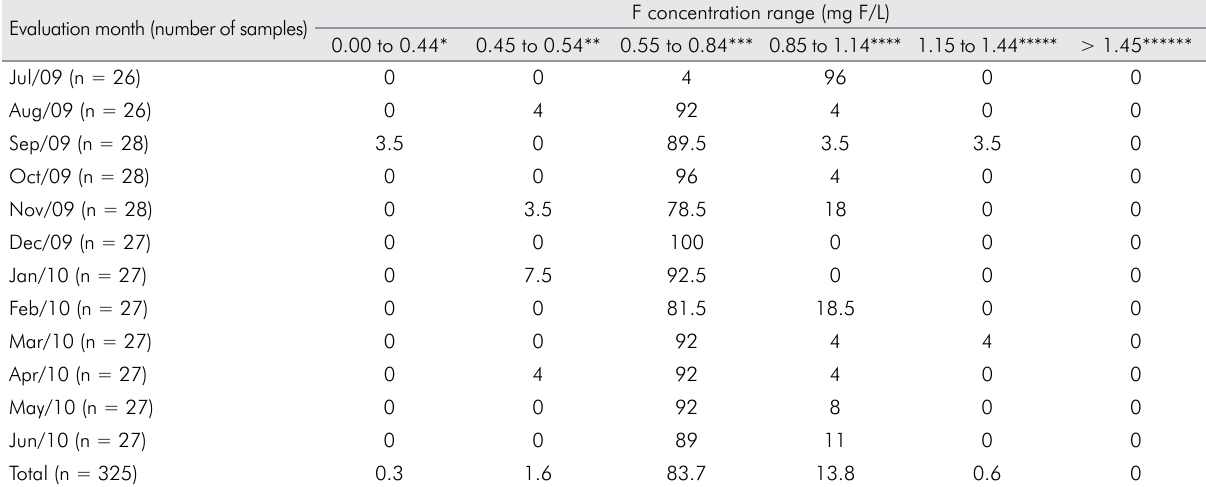
Table 2. Classification (%) of all water samples, from water treatment plants (WTPs) and artesian wells (AWs), classified according to the ranges of F concentrations regarding the risks and benefits, according to the month of